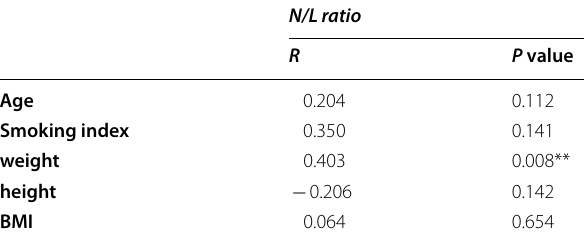
Table 3 Correlation between N/L ratio and demographic data